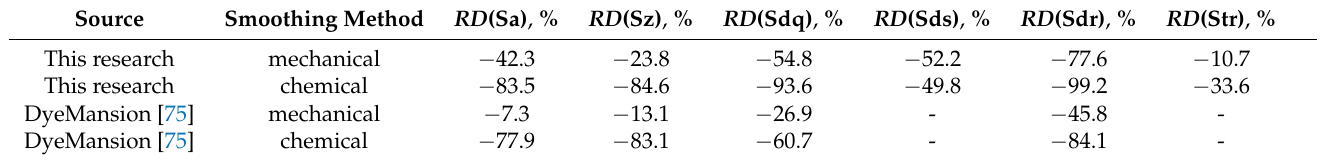
Table 5. Relative difference RD in the values of surface topography parameters after smoothing comparing to reference